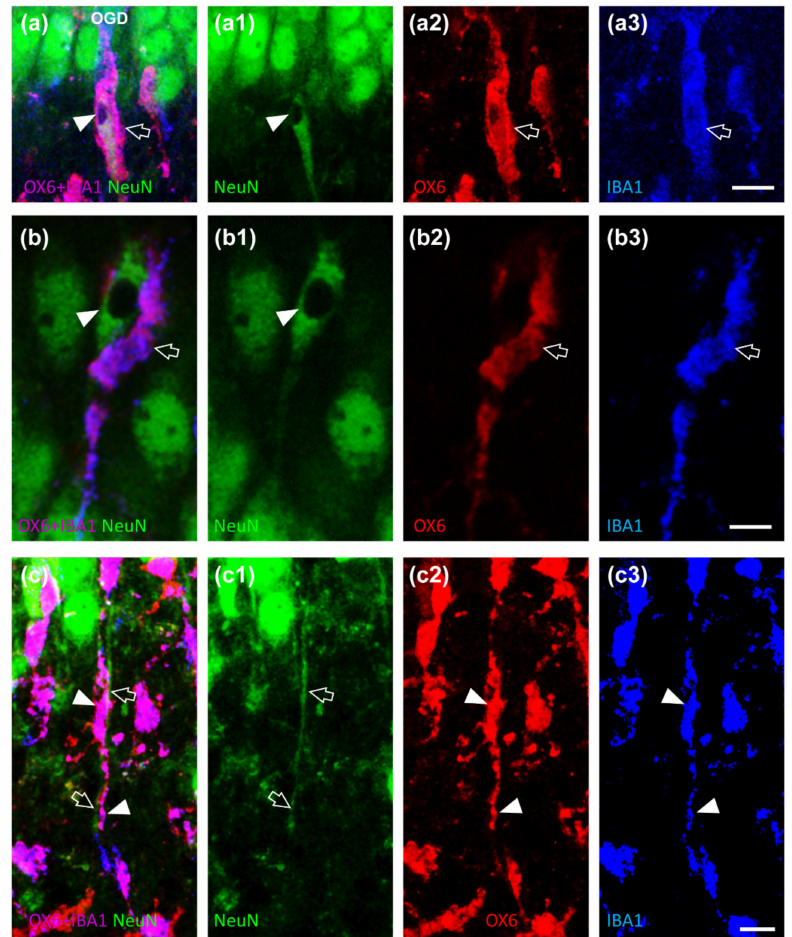
Figure 4. ( a – c3 ) Representative confocal images of NeuN-positive neurons (green, ( a1 , b1 , c1 )), OX6- positive active microglia (red, ( a2 , b2 , c2 )) and IBA1-positive total microglia (blue, ( a3 , b3 , c3 )) in CA1 SP of OGD organotypic hippocampal slices captured with a 63 × objective, stacking 5 consecutive confocal scans (z step 0.3 µ m, total thickness 1.5 µ m). The merge of the three immunofluorescent staining is shown in ( a – c ) in which the pink-purple color is indicative of active (OX6-positive) microglia cells (IBA1-positive). ( a – a3 , b – b3 ) It is possible to notice that active (OX6-positive, a2, b2, open arrow) microglia cells (IBA1-positive, a3, b3, open arrow) phagocytose an LDN neurons (NeuN-positive, ( a , a1 ), ( b , b1 ), arrowhead). Scale bar ( a – a3 ): 15 µ m. Scale bar ( b – b3 ): 7.5 µ m. ( c – c3 ) It is possible to notice in pink-purple color (( c ), arrowheads) an active (OX6-positive, ( c2 ), arrowheads) microglia cells (IBA1-positive, ( c3 ), arrowheads) adjacent to apical dendrites of pyramidal neurons that project in the SR (NeuN-positive, ( c , c1 ), open